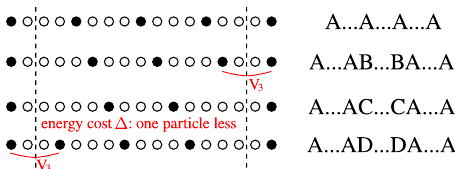
Fig. 4 Asymmetry of domain walls in the model with two-site blockade. For p = 4, domains with B or D inside A cost an energy V 3 while domains with C inside cost an energy Δ > V 3 since there is one particle less, leading to an asymmetry in the effective transverse fi eld